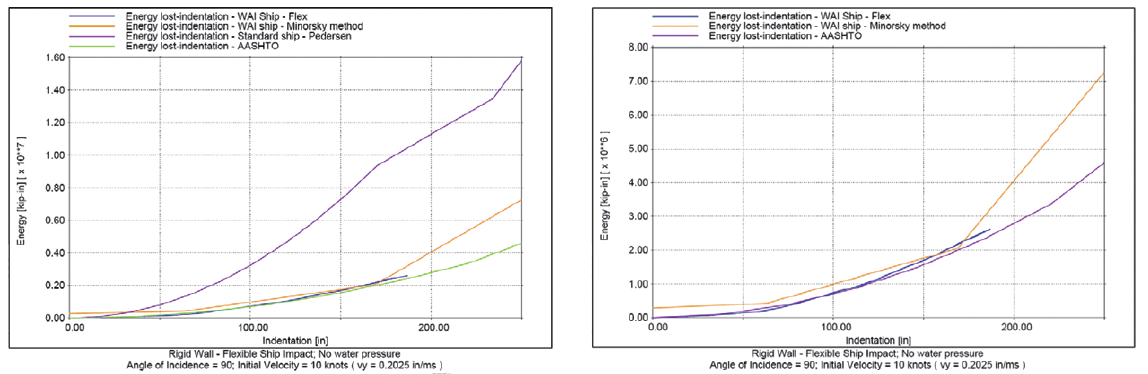
Fig. 11. Energy lost-Indentation history plots – comparison between numerical and analytical results (bottom plot – reduced energy